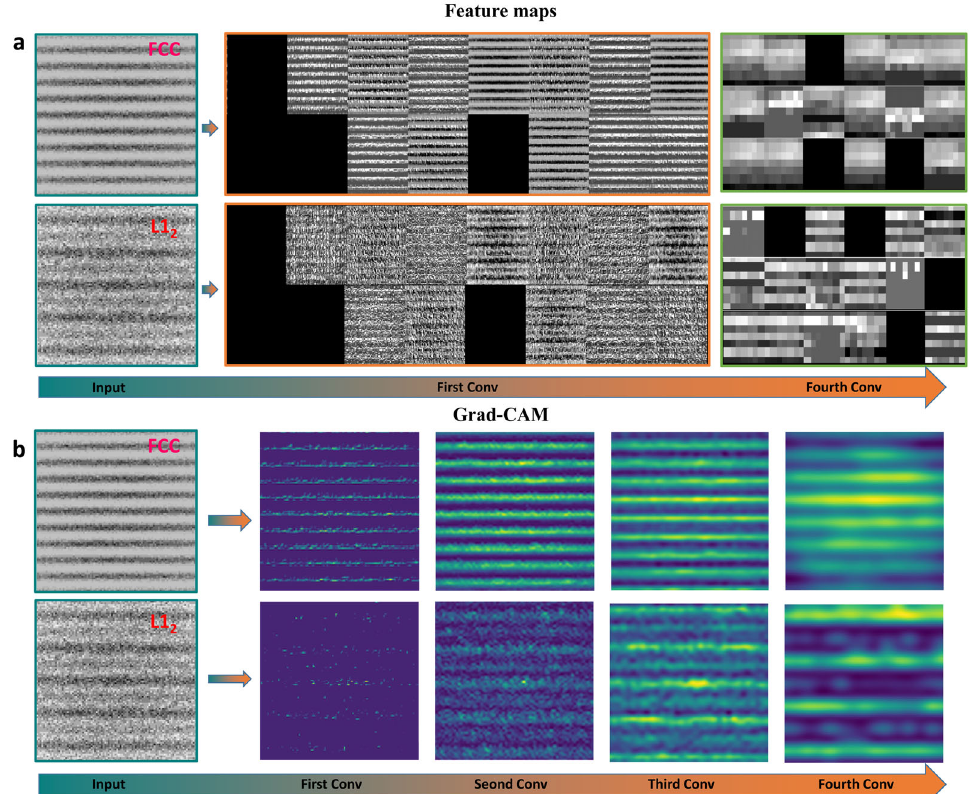
Fig. 7 Visualization of the CNN model. Part of ( a ) feature maps and ( b ) Grad-CAM of zx -SDMs of the simulated FCC and L1 2 structures after the fi rst to the fourth convolutional layers in the applied